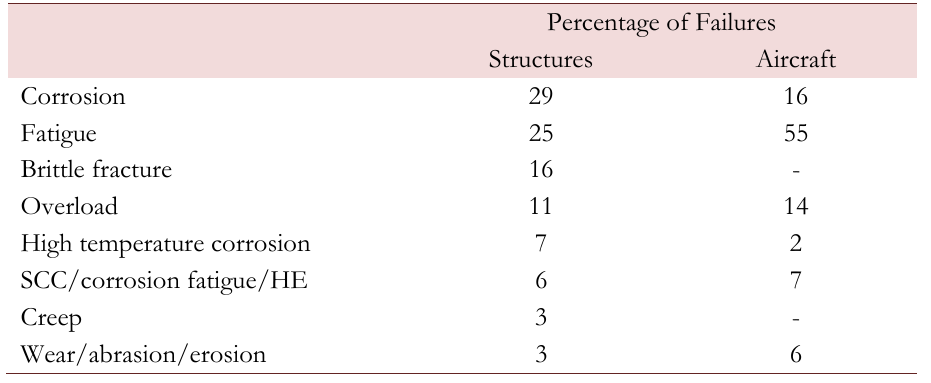
Table 1: Frequency of failure mechanisms in structures and aircraft [17]. In this table, HE represents hydrogen embrittlement and SCC stands for stress corrosion